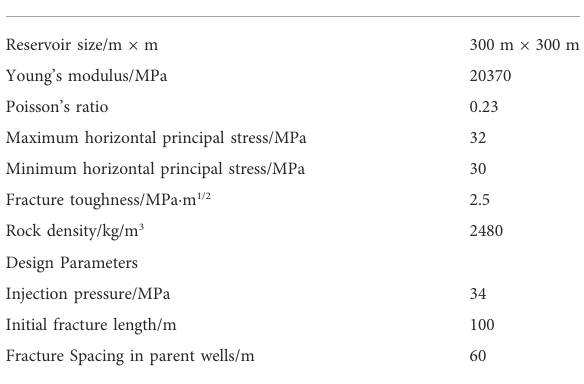
TABLE 1 Hydraulic fracturing simulation parameters. Formation